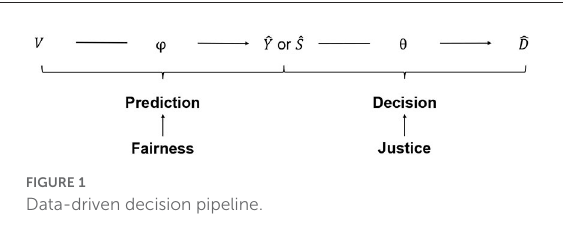
FIGURE1 Data-driven decision